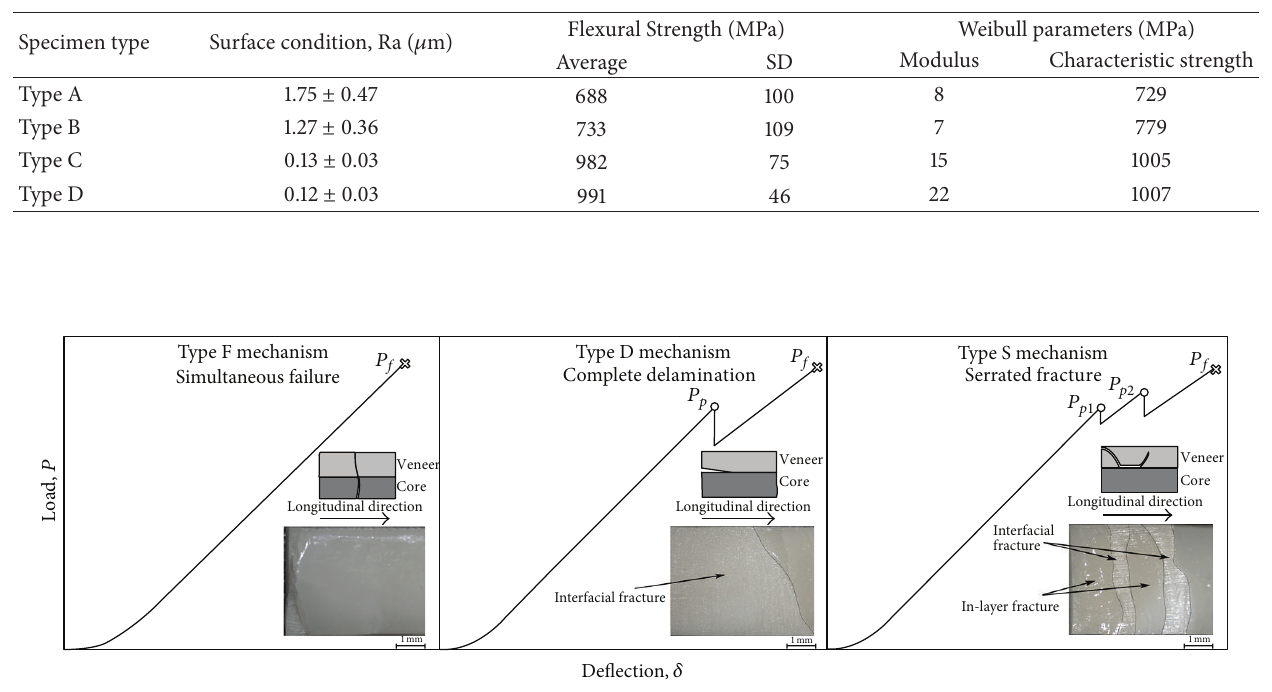
Figure 1: Failure mechanisms of the two-layered zirconia-veneer specimens together with schematic depictions of the force-deflection curves and optical observations of the fracture